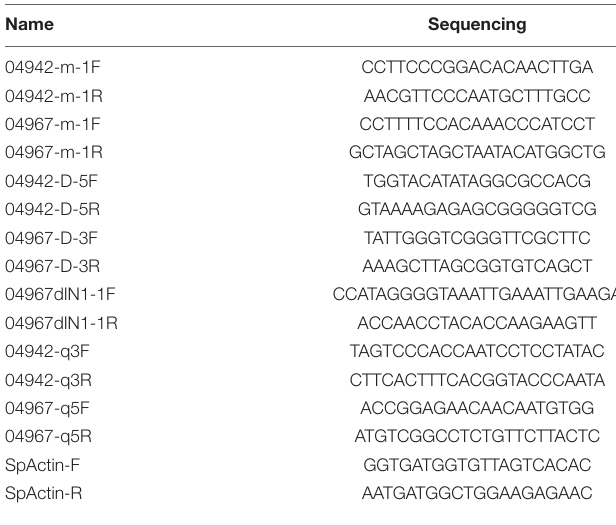
TABLE 2 | The primers used to screen candidate genes controlling spinach bolting